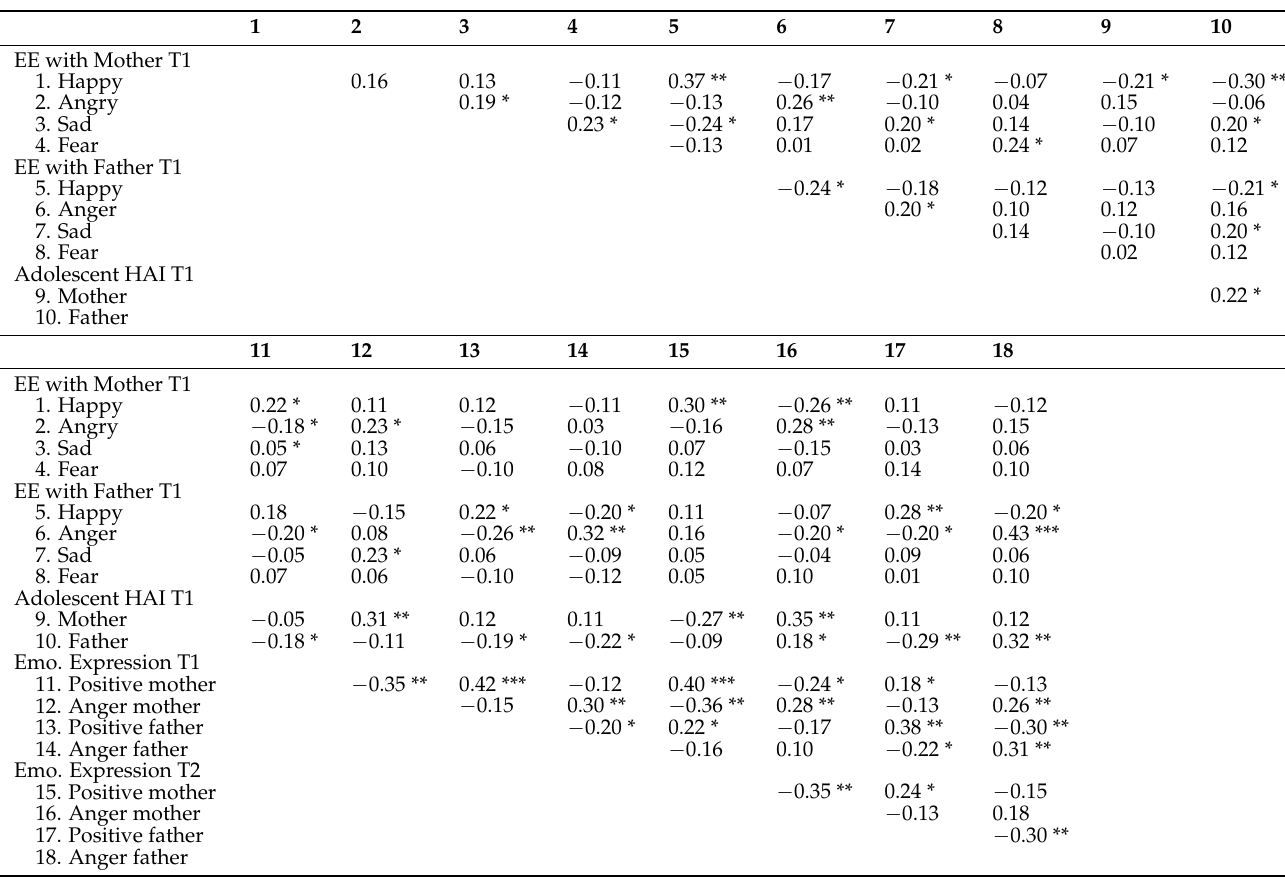
Table 3. Adolescent emotional expectancies and hostile attributions as predictors of adolescents’ expressions of emotion with